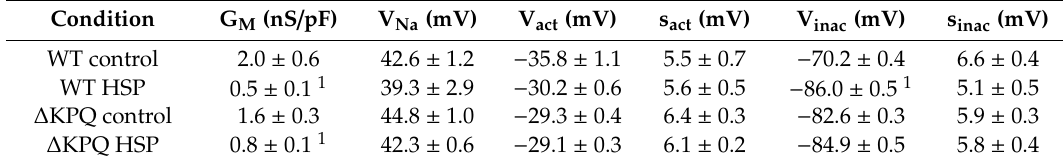
Table 1. Parameters obtained from the fits of the I–V relationships and availability curves. Condition G M (nS / pF)